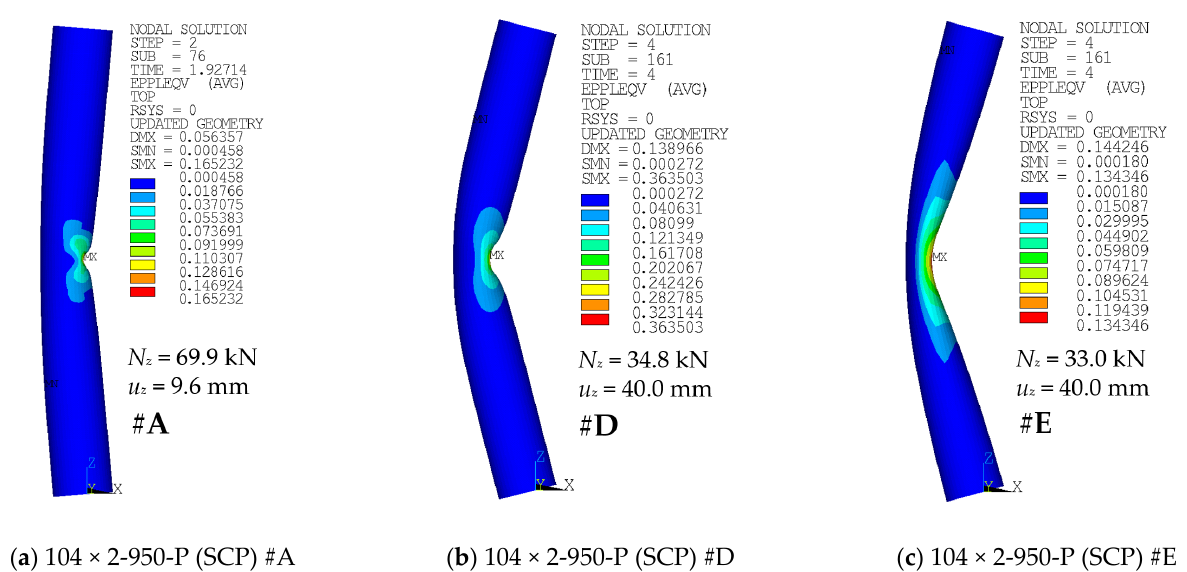
Figure 13. Equivalent plastic strains of various cases: ( a ) #A (SCP) curve from Figure 10; ( b ) #D (SCP) curve from Figure 10; and ( c ) #E (SCP) curve from Figure 10.